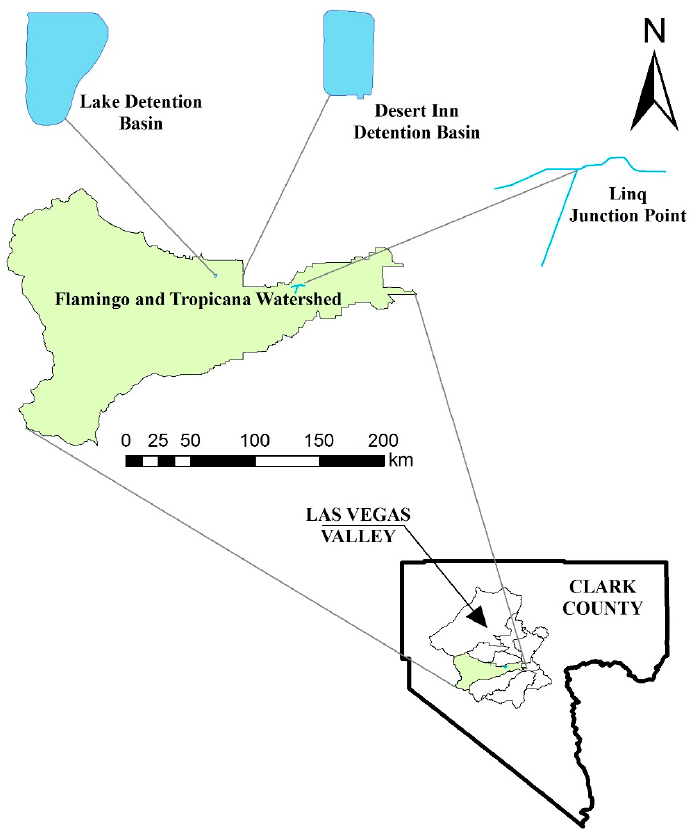
Figure 1. Map depicting the Flamingo and Tropicana watershed within the Las Vegas Valley, Nevada, along with the key drainage infrastructures that were analyzed for this study.